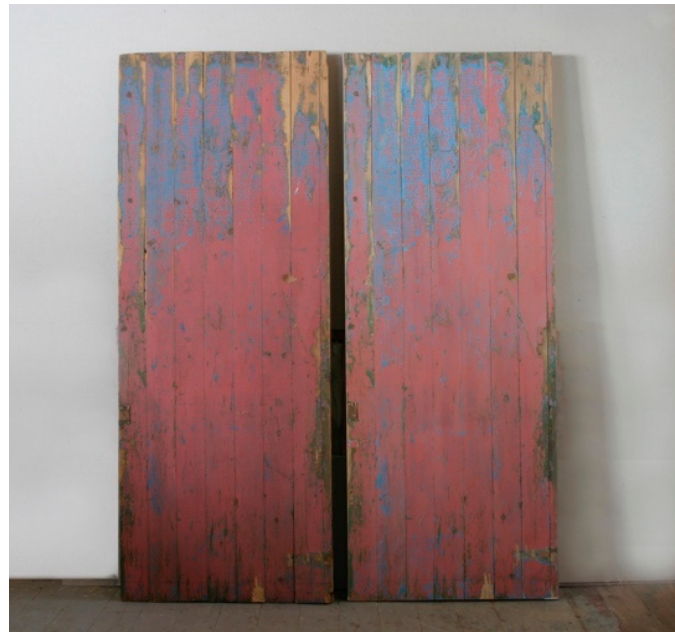
Figure 3. Replica (1982). Found door ( left ) with painted canvas ( right ), each panel 63 cm × 165 cm × 4